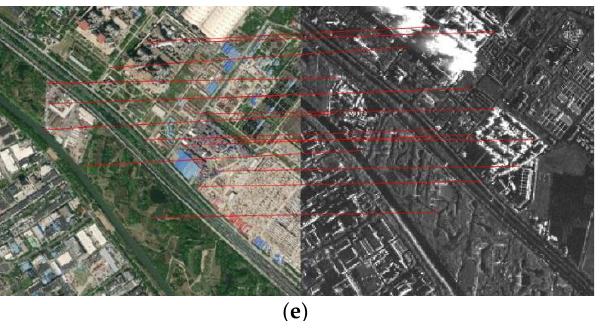
Figure 4. ( a ) Optical image; ( b ) SAR image; matches found in pair 3 using ( c ) SIFT, ( d ) SAR-SIFT, and ( e ) the proposed method. The reference image is shown on the left and the sensed image on the right. Table 1. Quantitative comparison of the proposed method with other SIFT-based algorithms. Image No. Image